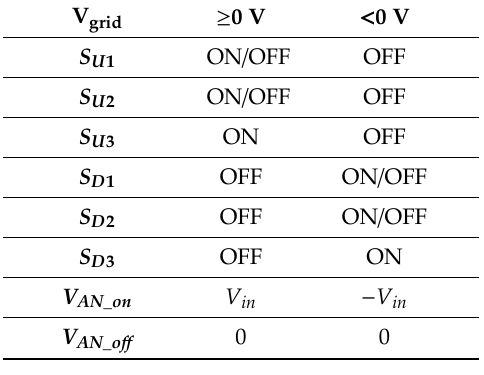
Table 1. Switching states and input voltages for inductors in the proposed inverter.